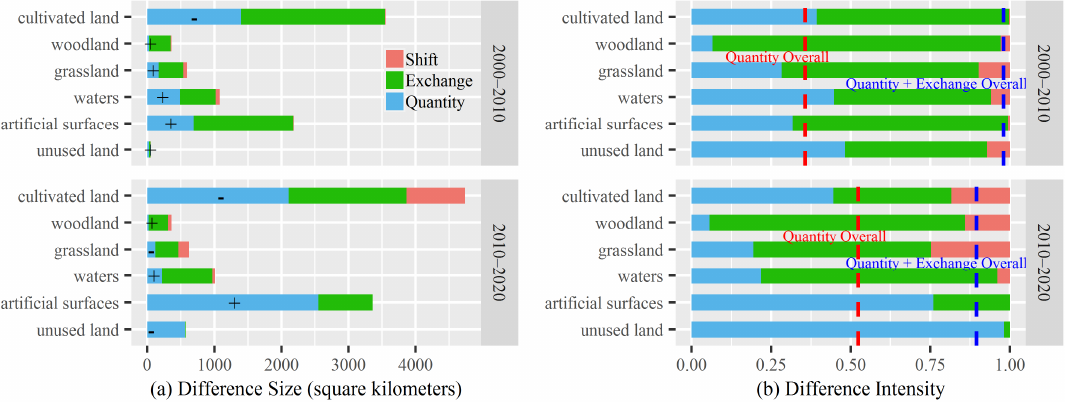
Figure 12. Size ( a ) and Intensity ( b ) of differences for the lower reaches of the YRB. The sign “+” denotes net gain and the sign “−” denotes net loss.